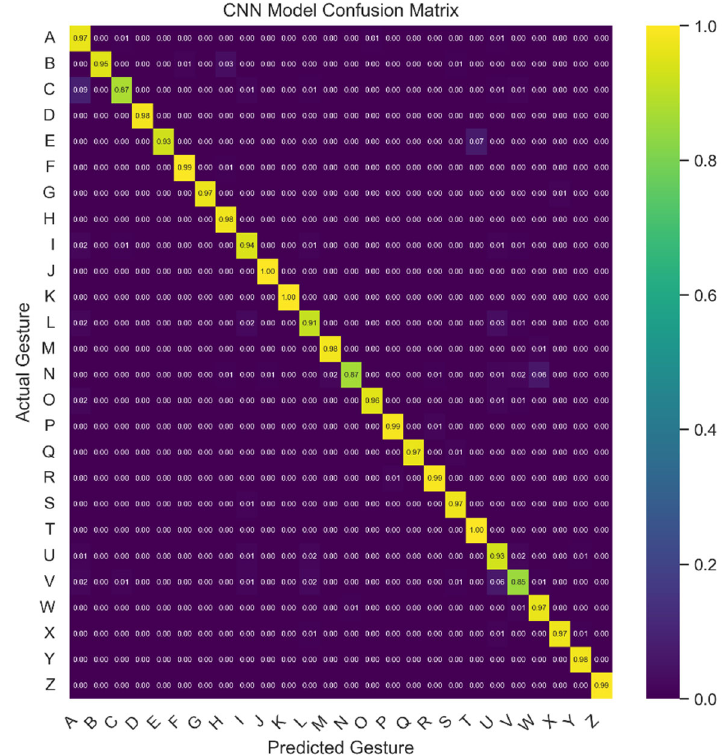
Figure 12. Confusion matrix generated using the CNN algorithm.